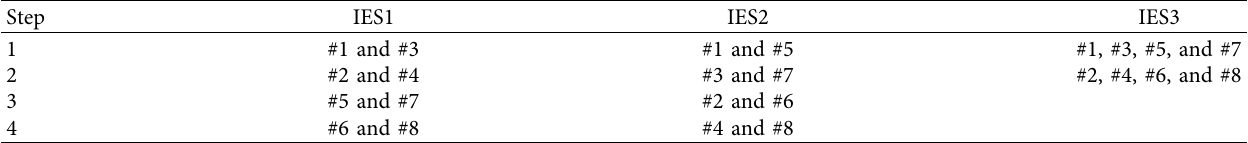
Table 2: Step of 3 IESs for 8